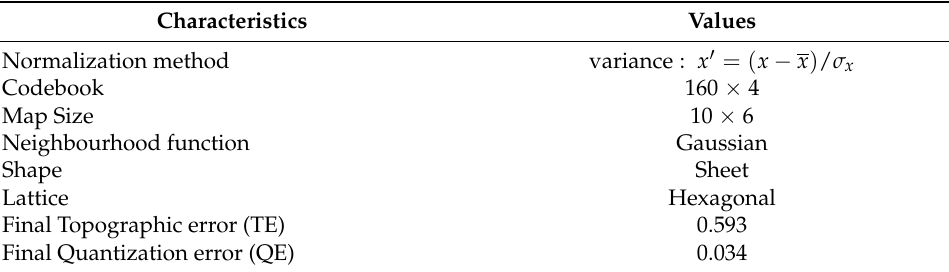
Table 3. Characteristics of trained Kohonen-SOM model.